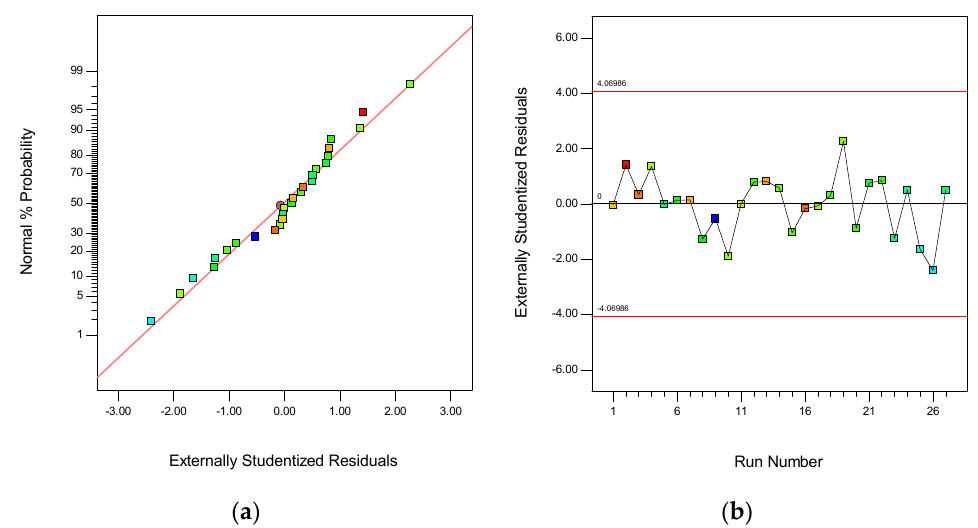
Figure 12. Diagnostic plots for flexural strength response: ( a ) normal probability; ( b ) residuals vs. run.